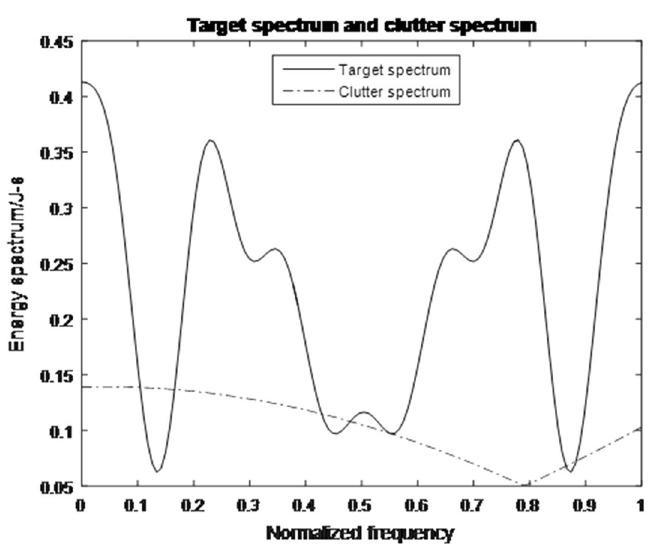
Fig. 5 Allocation of total target spectrum and clutter